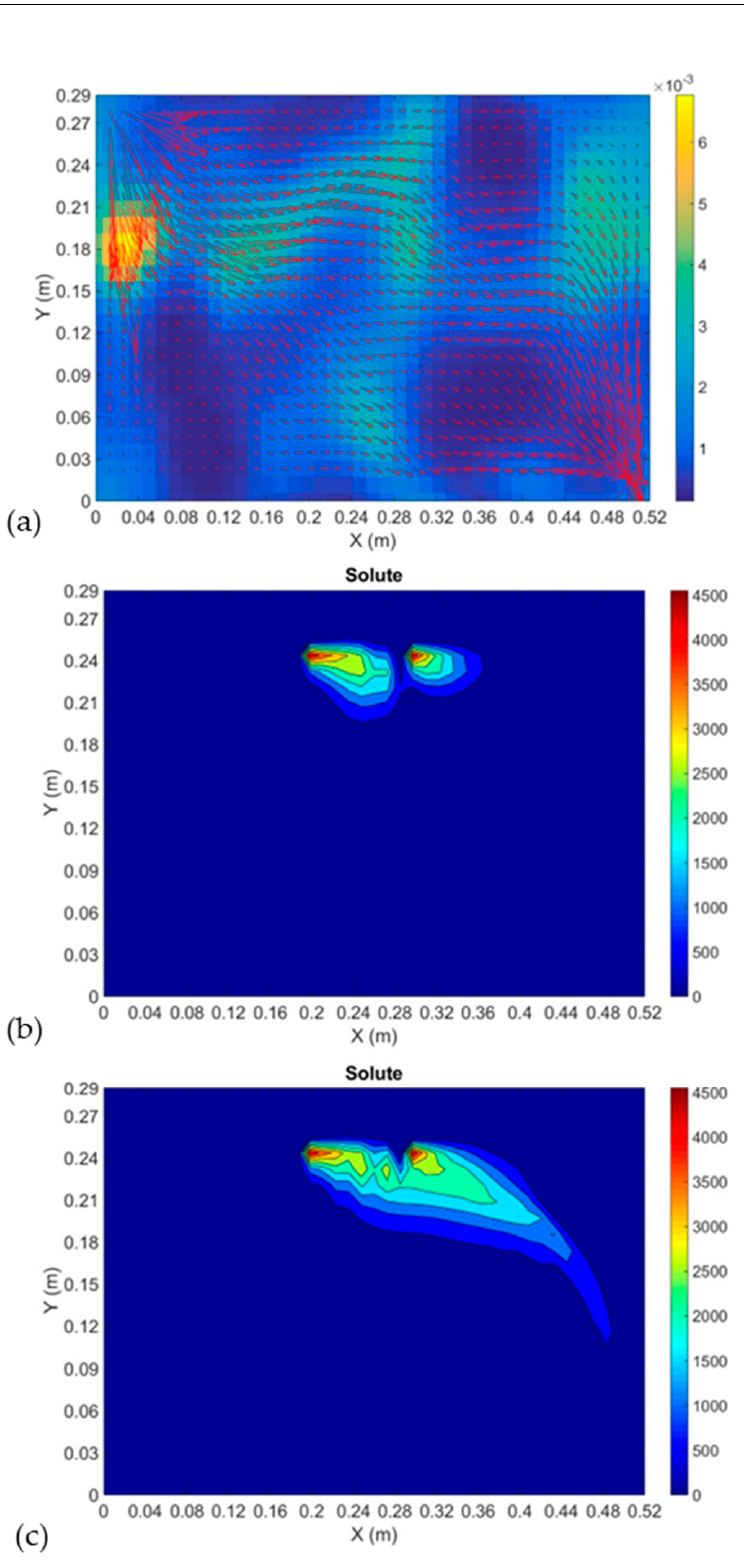
Figure 6. Numerical simulation of flow filed in a heterogeneous aquifer ( a ). The redistribution of a dissolved tracer simulated numerically at time = 2 min 11 s ( b ) and time = 10 min ( c ) .